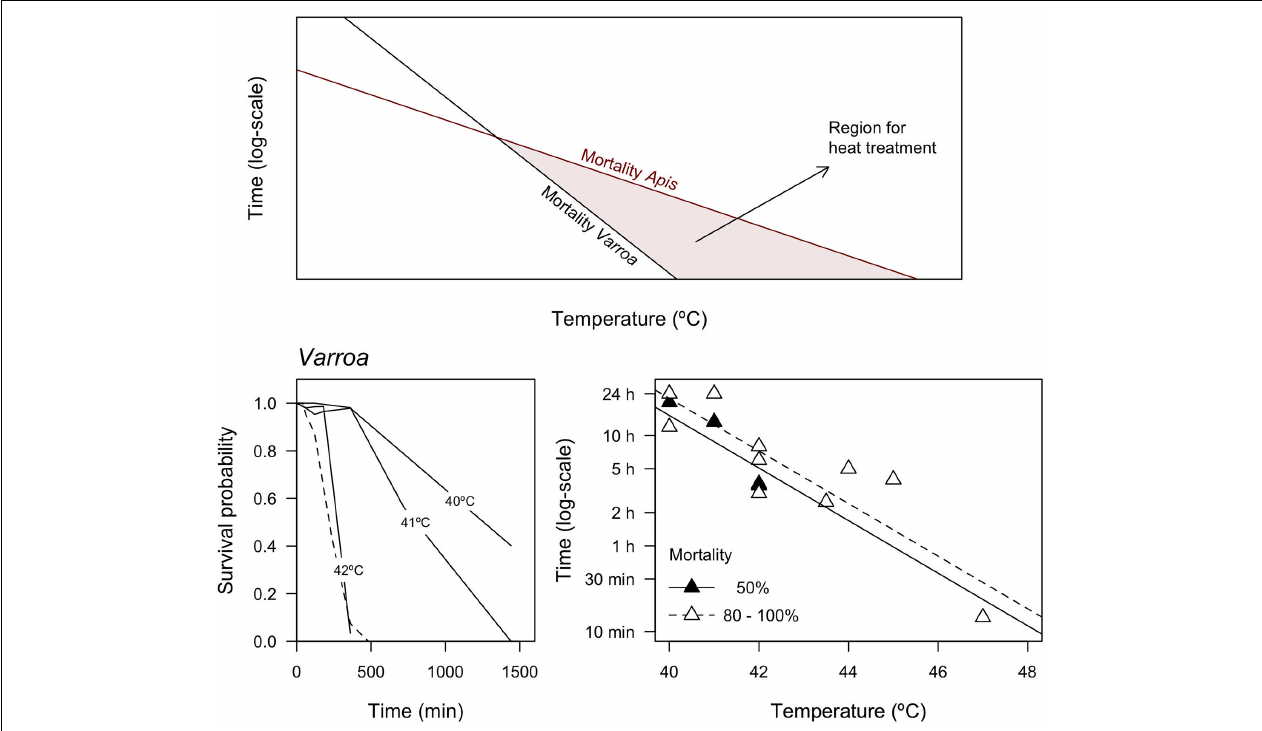
FIGURE 4 | Heat treatment based on TDT curves of the honeybee and Varroa (based on Tang et al., 2007), applicable where the thermal tolerance of bees is higher than that of Varroa. Survival curves and mortality data from the literature suggest that thermal mortality in Varroa complies with expectations from TDT curves. Mortality of 50% was interpolated from survival curves, continuous, and dotted lines represent different studies (see Table 3 ).